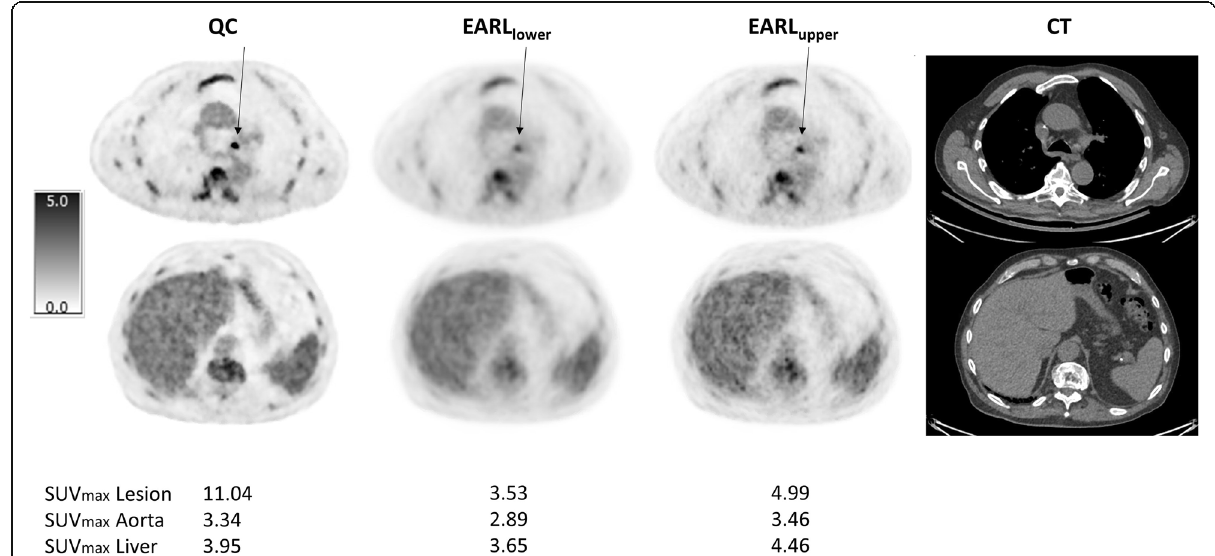
Fig. 1 Major discordance in DS. Representative example of patient who had major discordance between QC, EARL lower and EARL upper DSs. This patient was classified as DS 5 on QC images, DS 3 on EARL lower images and DS 4 on EARL upper images. Transversal images in the thorax (aorta and lesion (indicated with an arrow) with highest SUV max ) — upper row — and in the abdomen (liver) — lower row — for the three different reconstructions including the corresponding CT are shown